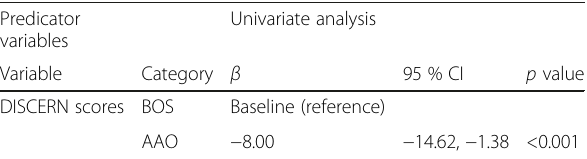
Table 3 Univariate median regression-derived coefficients ( β ) and 95 % confidence intervals (CI) for quality scores